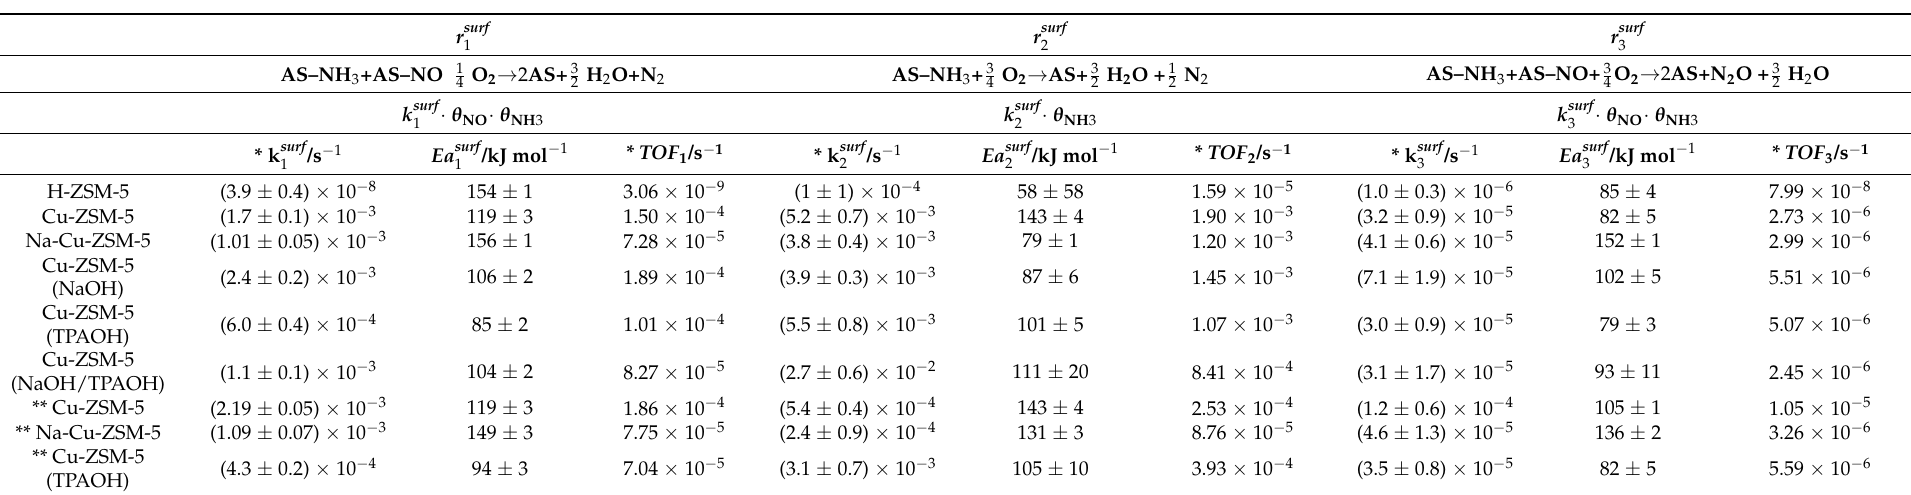
Table 7. Calculated kinetic parameters for surface